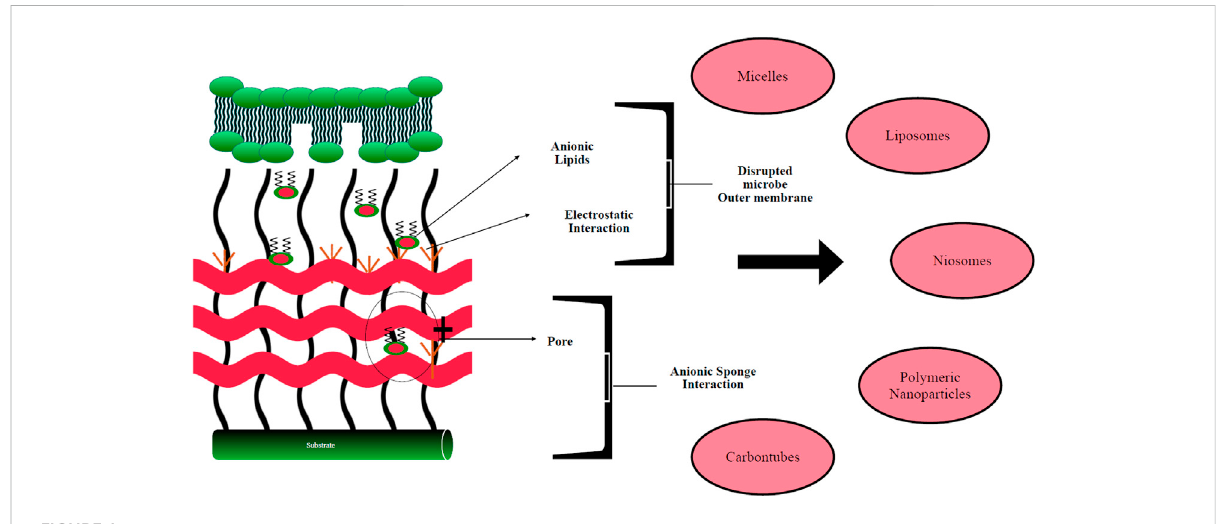
FIGURE 1 Self-assembled